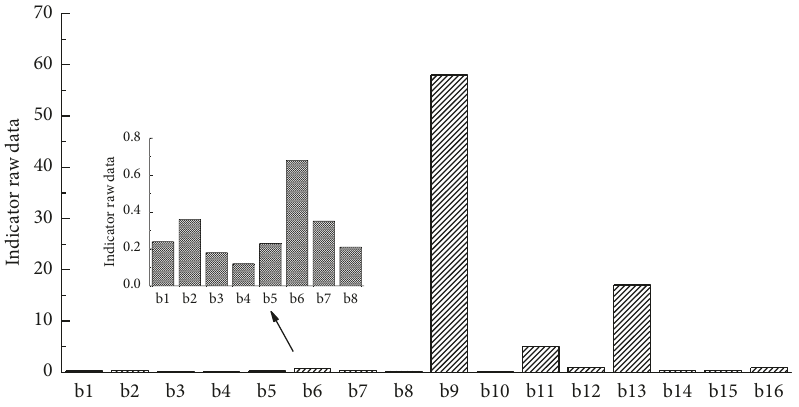
Figure 6: The performance indicators of Company